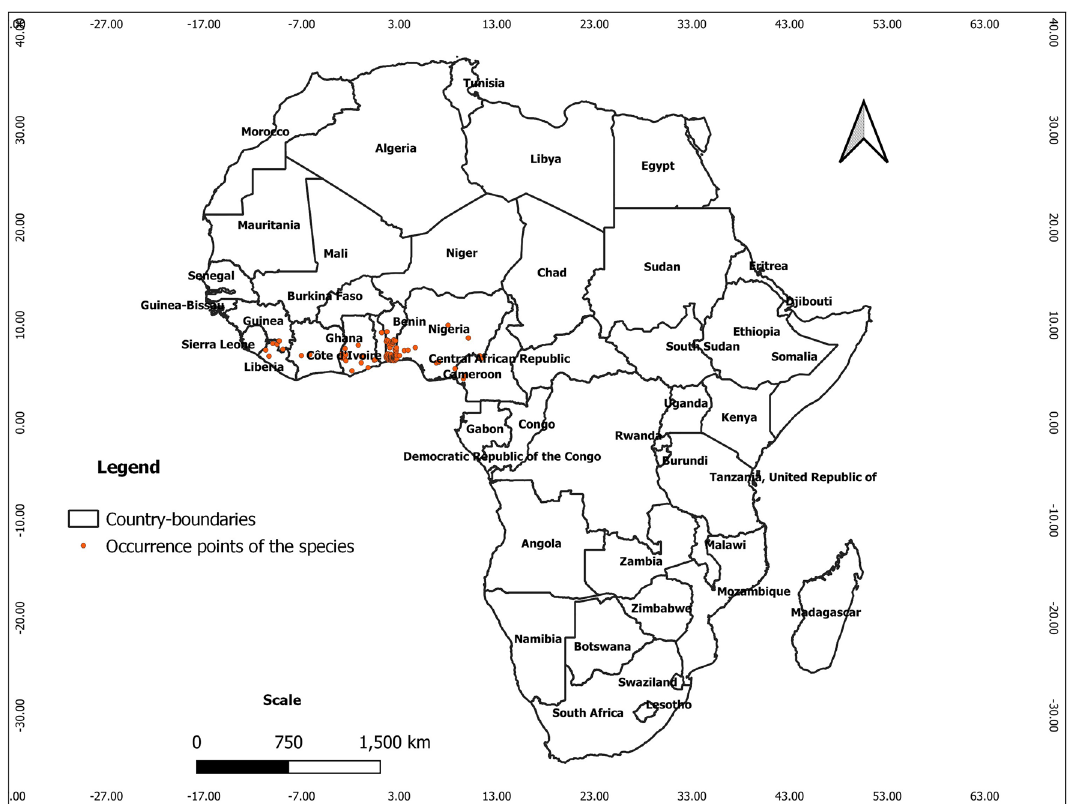
Figure 1. Spatial distribution of the occurrence points of C. albidum across Africa (the map was generated using QGIS 3.18.1 (http:// qgis. osgeo. org) and WGS 84 as Coordinate Reference System). Source of occurrence points: GBIF.org (1 March 2021) GBIF Occurrence Download https:// doi. org/ 10. 15468/ dl.